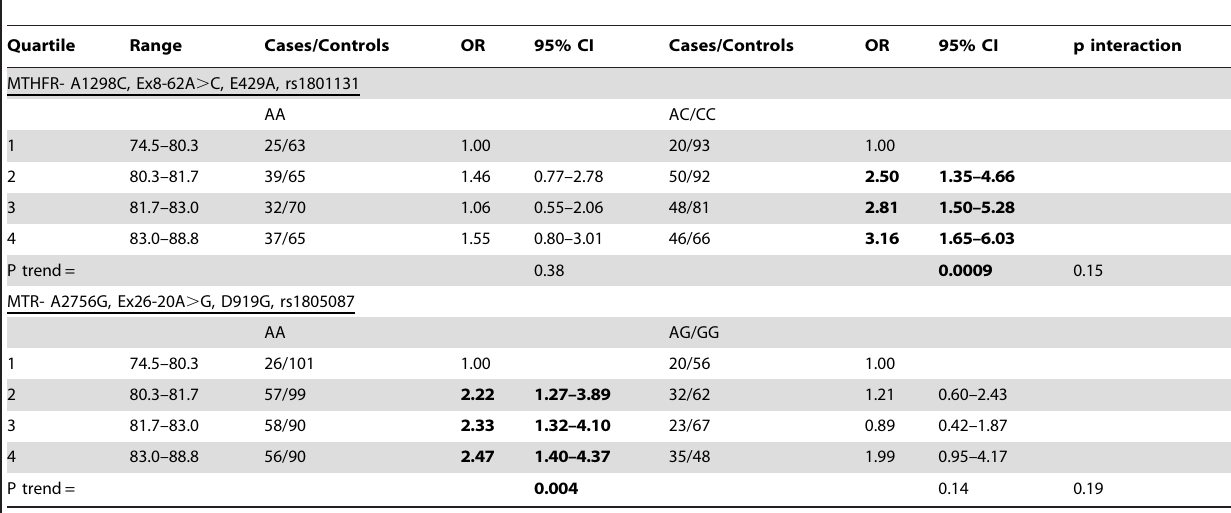
Table 3. Modification of Association between LINE-1 methylation and RCC risk by selected polymorphisms.